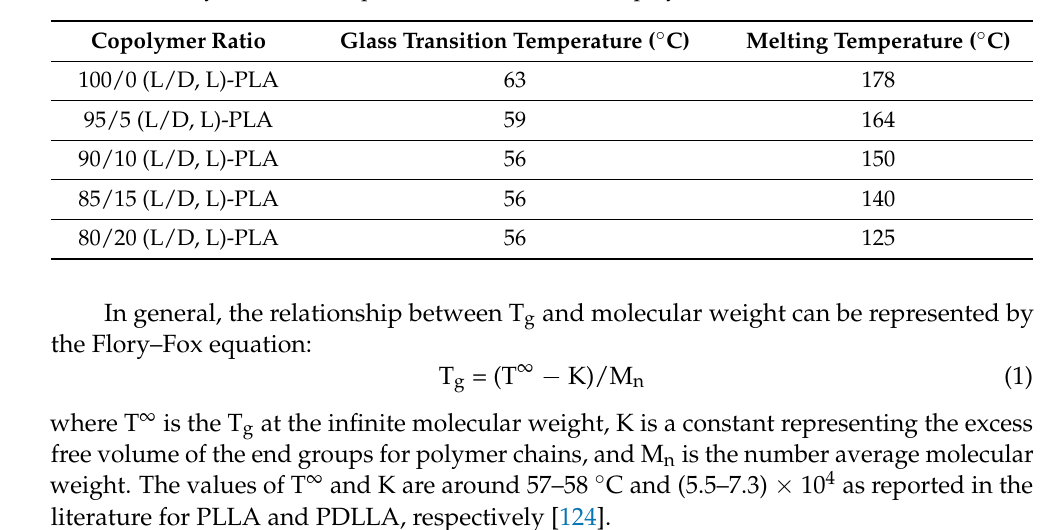
Figure 6. Glass transition temperature for PLAs of different L-contents as a function of molecular weight (Reproduced with a copyright permission from Naser et al. [123]). Table 5. Primary transition temperature of selected PLA copolymers [96].